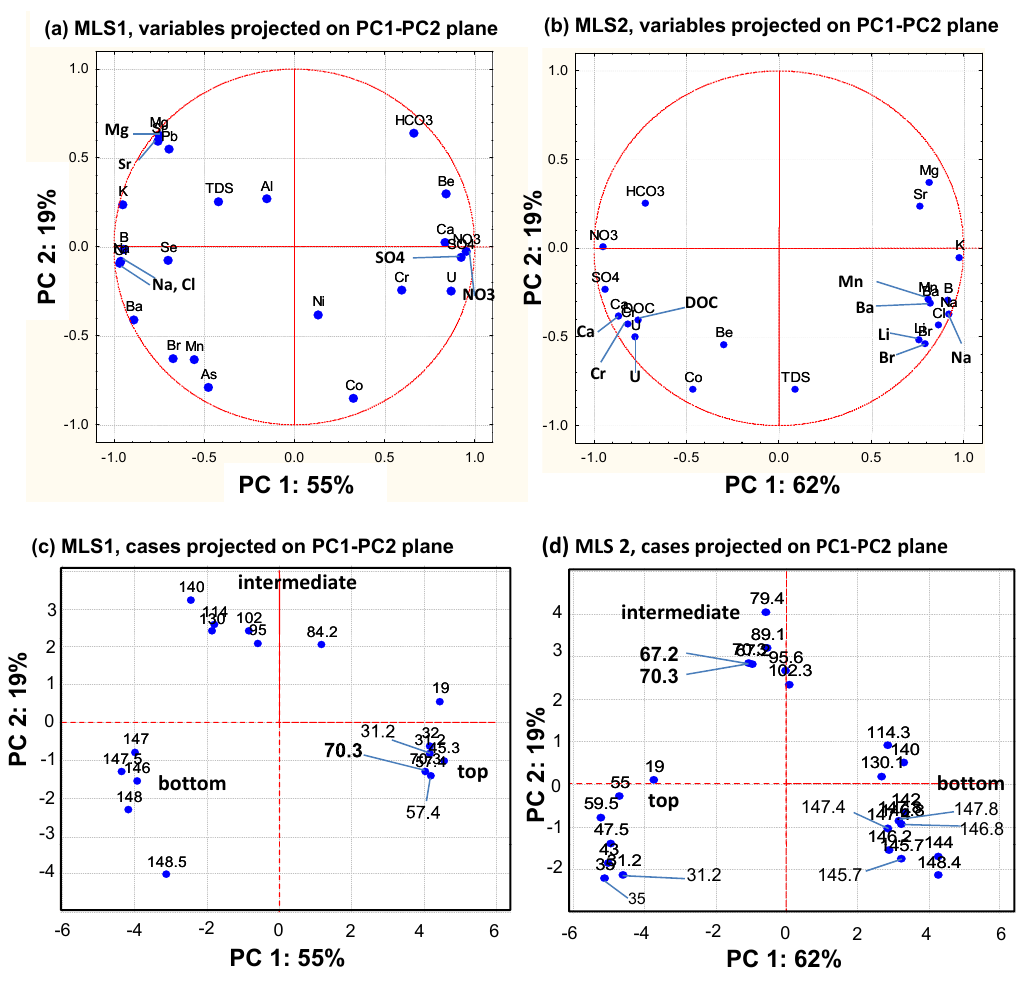
Fig. 7. Principal component analysis (PCA) of the multilevel sampling (MLS) campaigns. Variables (a , b) and cases (c , d) are projected on the plane of the first two principal components. Cases are labeled by the sampling depth in meters below ground level (mb.g.l.). Top, intermediate and bottom groups of cases are distinct. Oxidation states of ions were omitted for graphical